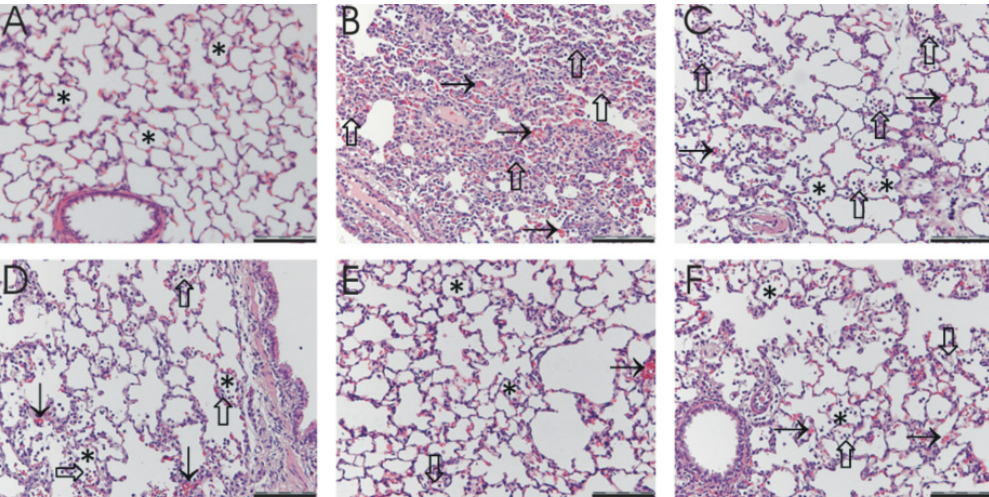
Figure 6. Histopathological examination of H&E stained lung tissues collected from: ( A ) non-challenged (negative control), ( B ) LPS-challenged (positive control) rats without treatment and ALI-bearing rats treated with ( C ) Dexa, ( D ) paeonol, ( E ) Compound 4 , and ( F ) Compound 4.HCl . Rats were consequently sacrificed at 8 h after intratracheal administration of LPS (8 mg/kg). The alveolar spaces ( ∗ ) filled with the mixture of red blood cells ( → ) and mononuclear/neutrophilic infiltrates ( ⇧ ) combined with biological responses observed in BALF were integrated to comprehensively evaluate therapeutic efficacy of APDs. (Scale bar: 100 µm)